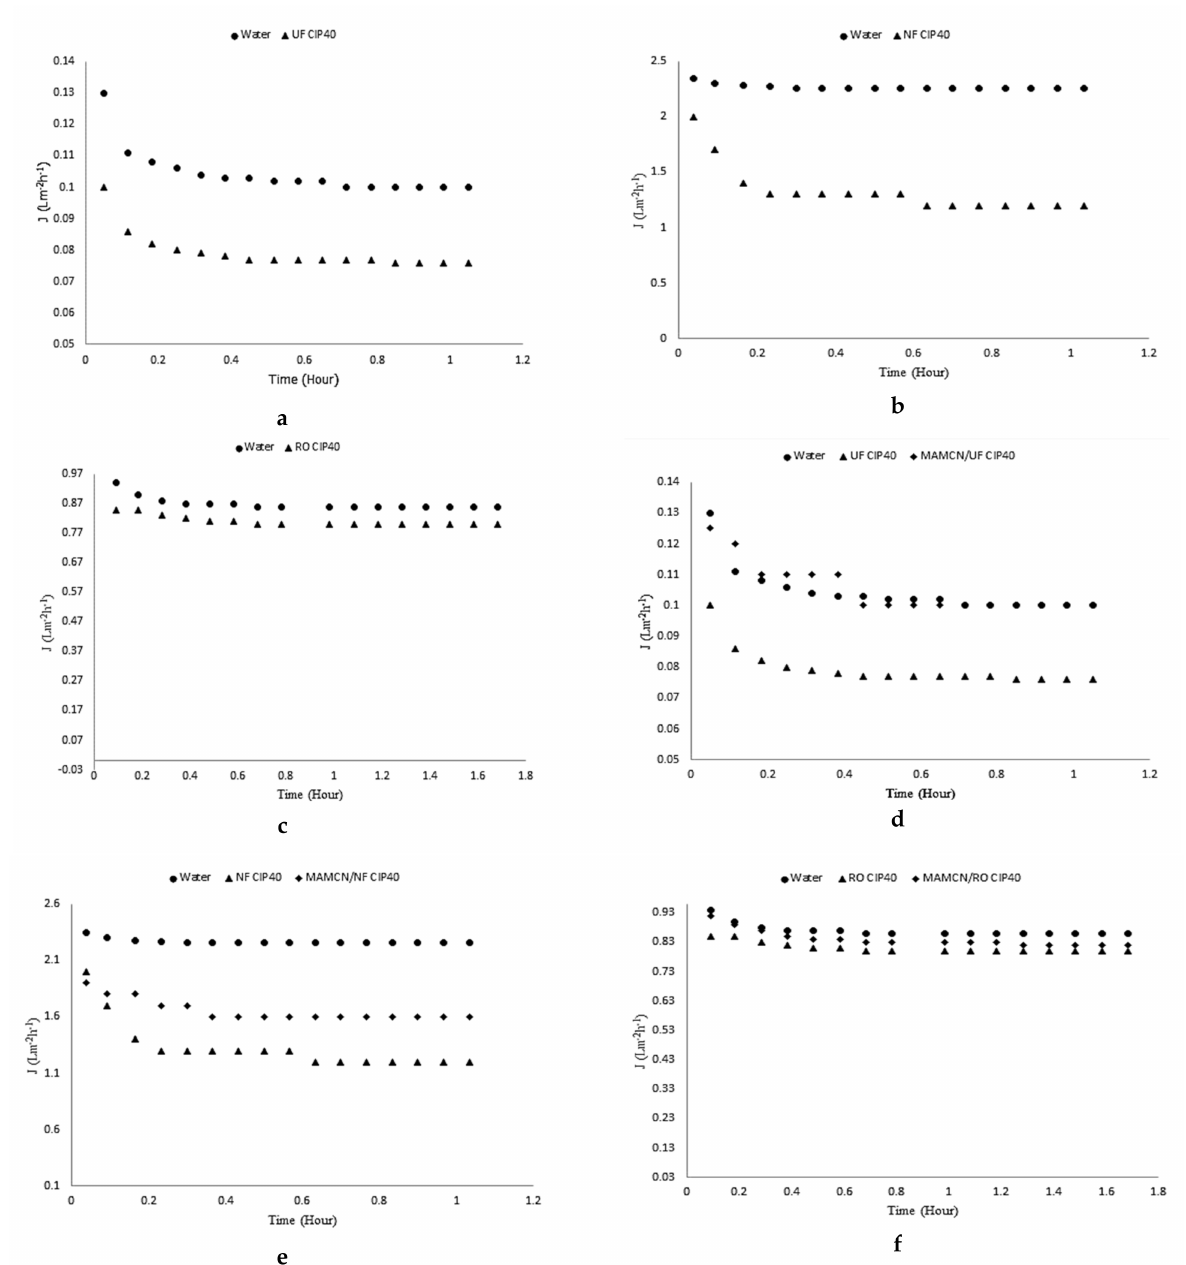
Figure 6. ( a ) Effect of CIPRO on permeate flux of UF membrane. ( b ) Effect of CIPRO on permeate flux of NF membrane. ( c ) Effect of CIPRO on permeate flux of RO membrane. ( d ) Improved permeate flux of UF membrane with mango Fe 3 O 4 /C. ( e ) Improved permeate flux of NF membrane with mango Fe 3 O 4 /C. ( f ) Improved permeate flux of RO membrane with mango Fe 3 O 4